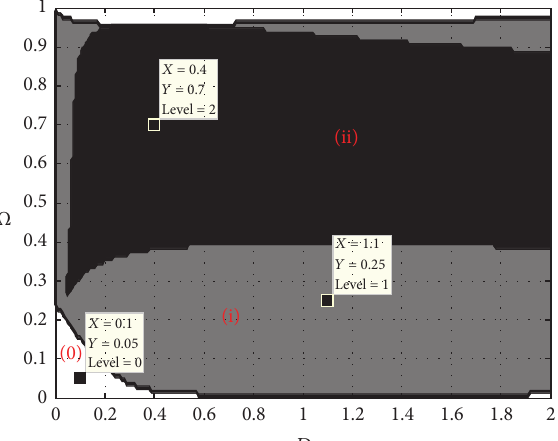
Figure 4: The phase diagram for the stochastic resonance behaviors of the output amplitude 𝐴(𝑎 2 ) at 𝜔 2 0 = 1 , 𝐴 1 = 1 , 𝛼 = 0.6 , 𝜏 = 0.2 , 𝐴 2 = 1 , 𝛾 = 0.3 , and V = 0.05 , and the values of level in Figure 3 reflect the number of SR peaks for different combination of 𝐷 and Ω .